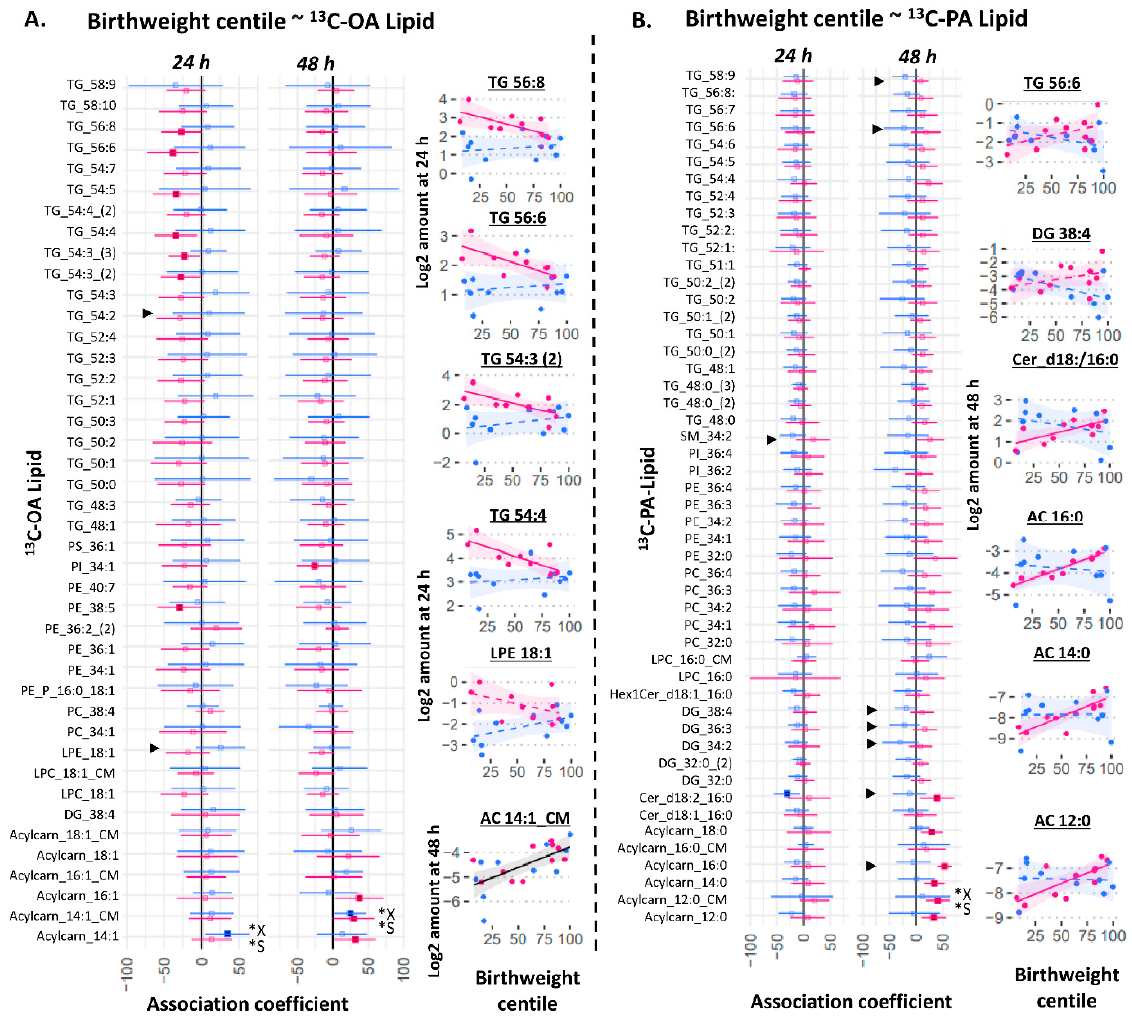
Figure 5. Sex-stratified associations between birthweight centile (outcome) with the amount of placental 13 C-OA lipid ( A ) or 13 C-PA lipid ( B ) after 24 or 48 h of culture. Birthweight centile was standardized for gestational age by local references. X* represents p < 0.05 in linear regression with males and females combined (not shown). S* represents p < 0.05 in linear regression adjusted for sex (not shown). ► represents significant p < 0.05 for the interaction between sex and amount of lipid on birthweight centile. Linear regression was then run separately for males and females (shown in figure). Forest plots (A,B) show association coefficient and 95% confidence intervals for males (blue) and females (red) with significance ( p < 0.05) shown by dark-colored filled squares. Unadjusted scatter plots illustrating the relationship between birthweight centile and amount of lipid. The Benjamini–Hochberg method was used to correct for multiple testing. Abbreviations: Acylcarn and AC: Acylcarnitine, DG: diacylglycerol, Cer: ceramide, Hex: hexose, LPC: lysophos- phatidylcholine, LPE: lysophosphatidylethanolamine, OA: oleic acid, PA: palmitic acid, PC: phos- phatidylcholine, PE-P: phosphatidylethanolamine-plasmalogen, TG: triacylglycerols.